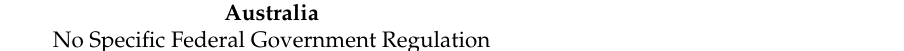
Table 1. Provisions within laws and policies for managing mobile zoos by country, state or